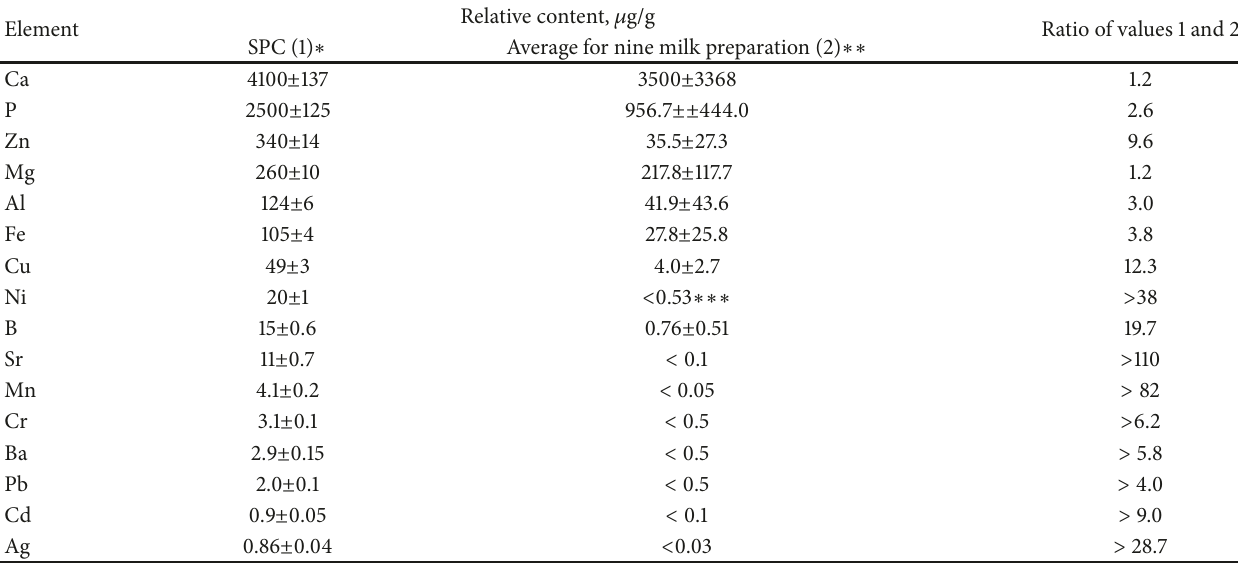
Table 1: The comparison of the content of elements in the lyophilized preparations SPC mix (from nine milk preparations) and lyophilized defatted milk